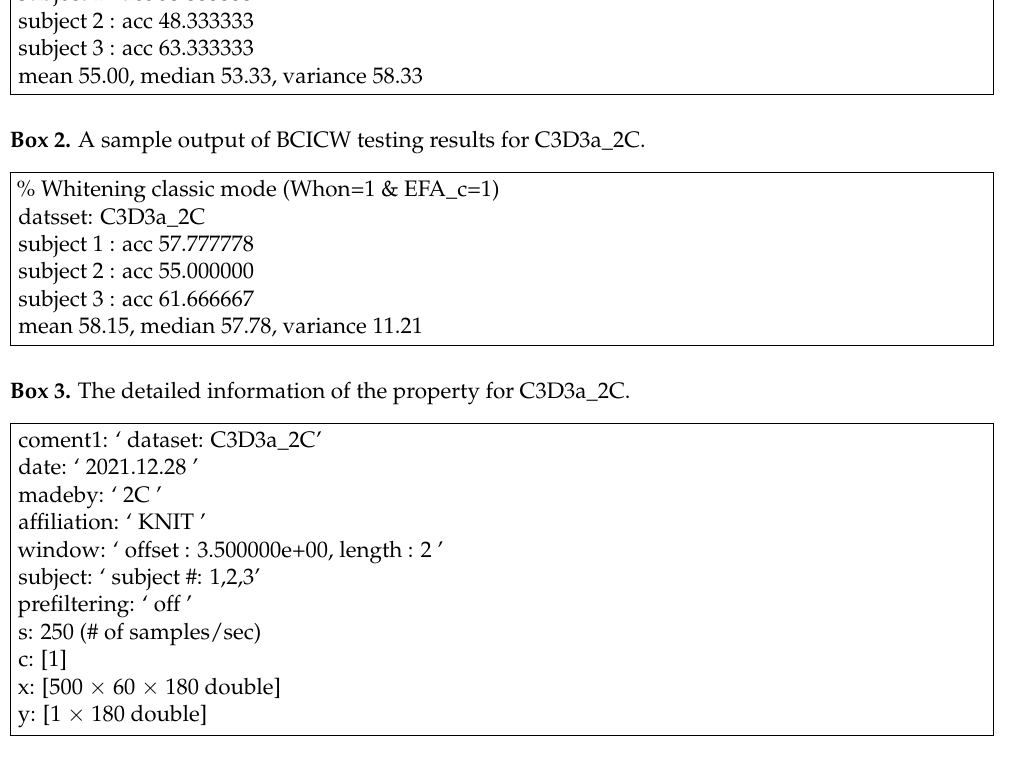
Figure 6a,b present the covariance matrix of C3D3a_2C for the first subject when the EFA method was applied. Figure 6c,d depict the covariance matrix of C3D3a_2C for the first subject when BCICW was